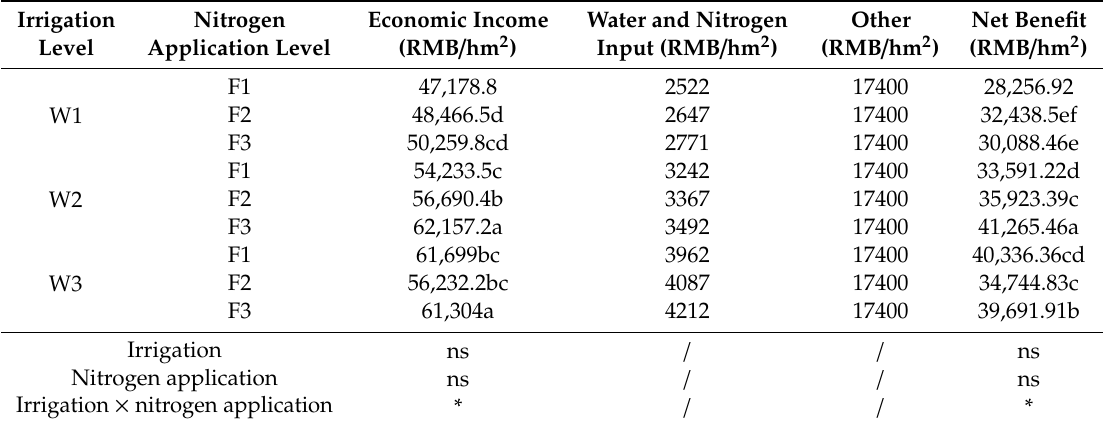
Table 5. Income and expenditure for jujube for water and nitrogen treatments.